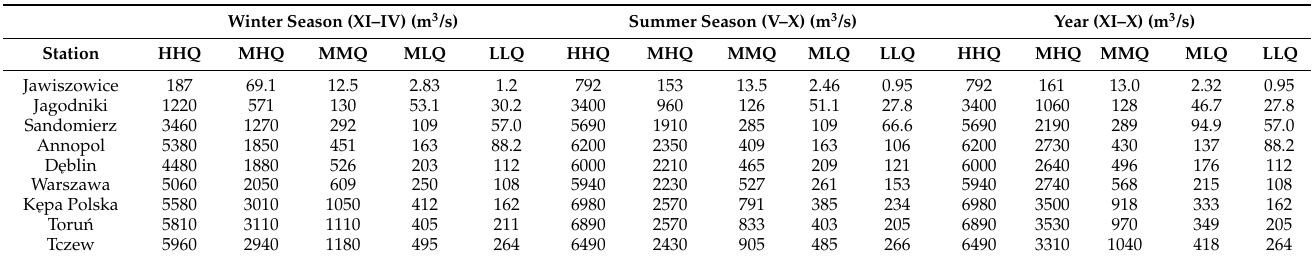
Table 5. The characteristics of seasonal and annual flow at selected stations in the 1951–2018 period. HHQ—the highest of the highest flow in the period, MHQ—the mean highest flow; MMQ—the mean flow; MLQ—the mean lowest flow; LLQ the lowest of the lowest flow.